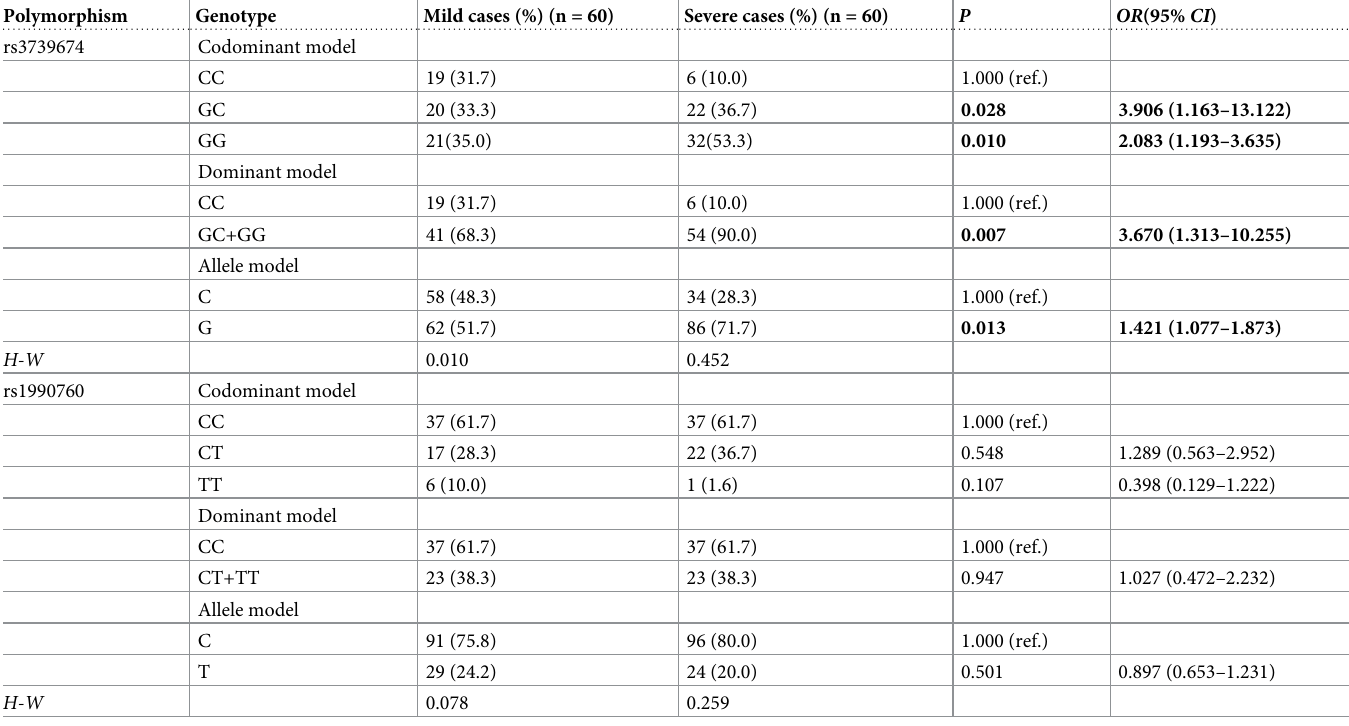
Table 4. DDX58 rs3739674 and IFIH1 rs1990760 genotype distribution and allele frequencies in the mild and severe HFMD groups. Polymorphism